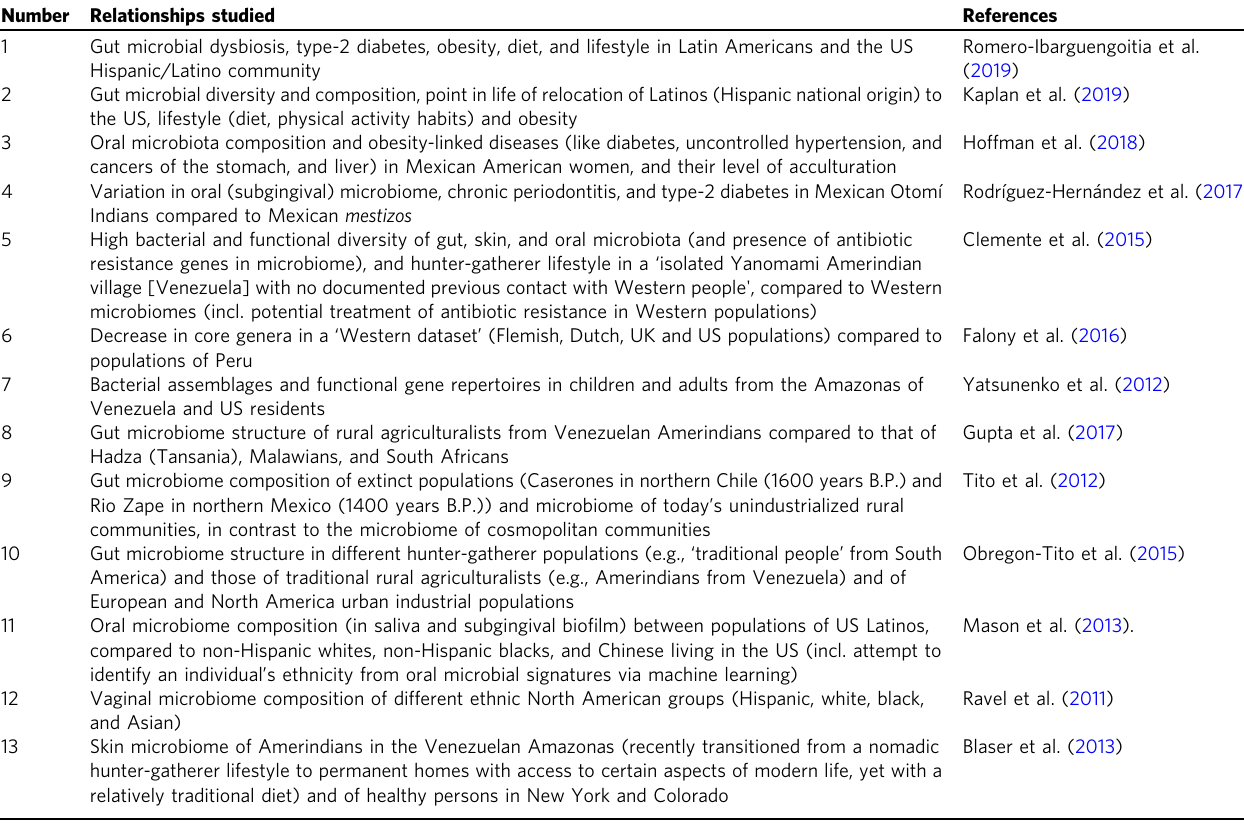
Table 1 Examples of microbiome studies on human populations in or from Latin America. Number Relationships